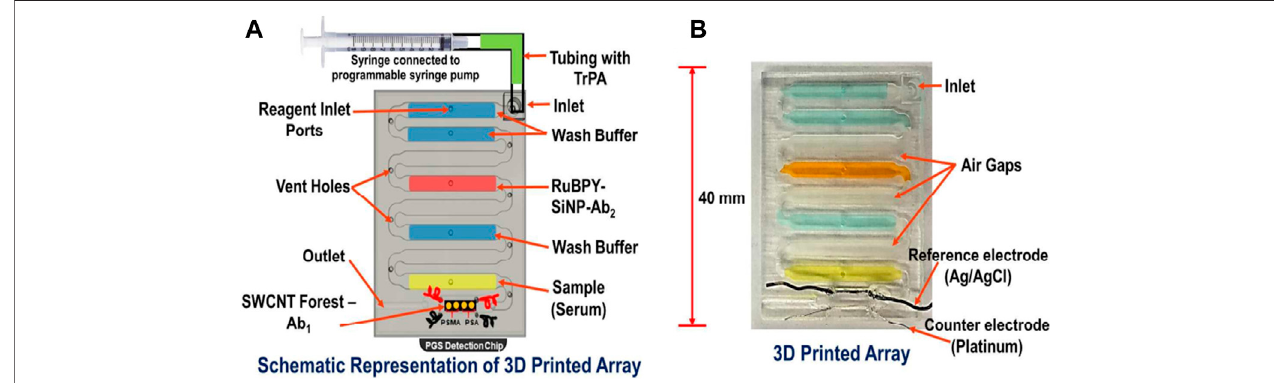
FIGURE 11 | (A) Model of an array with labelled reagent chambers connected to 4 microwells pyrolytic graphite (PGS) detection chip. (B) Picture of a 3D printed micro fl uidic array and fl uidic chambers fi lled with colored dyes for identi fi cation. (Reproduced with permission from Kadimisetty et al., 2018b).